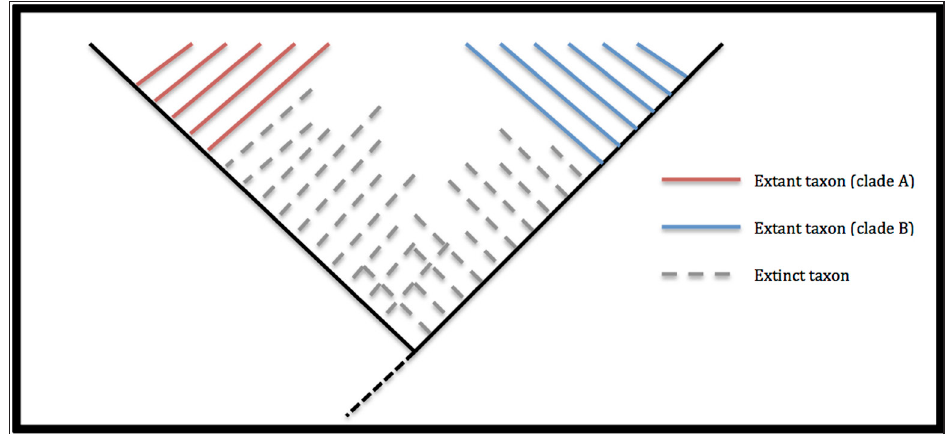
Figure 2: Diagram to illustrate Cartmill’s (2012) suggestion that the observable dif- ference between extant clades are due to anagenesis and the extinction of species. In the above schematic cladogram, the grey dotted lines represent extinct lineages that create the illusion of distinctiveness between the extant clades, which are represented by solid lines in red and